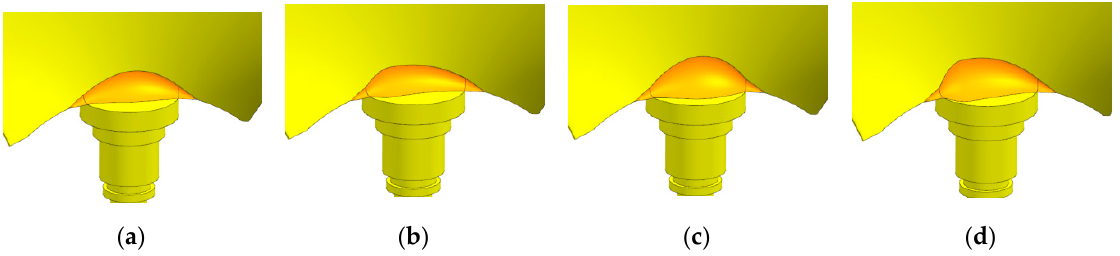
Figure 10. Finite element model of blades with four different root thicknesses: ( a ) Model 1, ( b ) Model 2, ( c ) Model 3, and ( d ) Model 4.